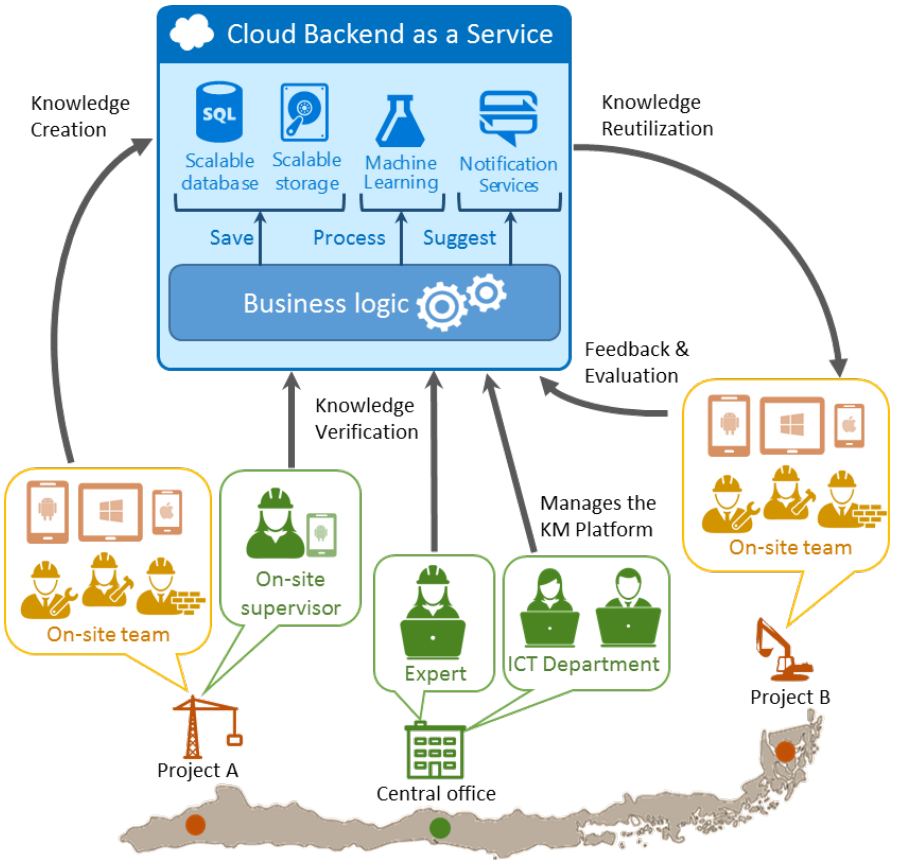
Figure 2. General overview of the use of the KM